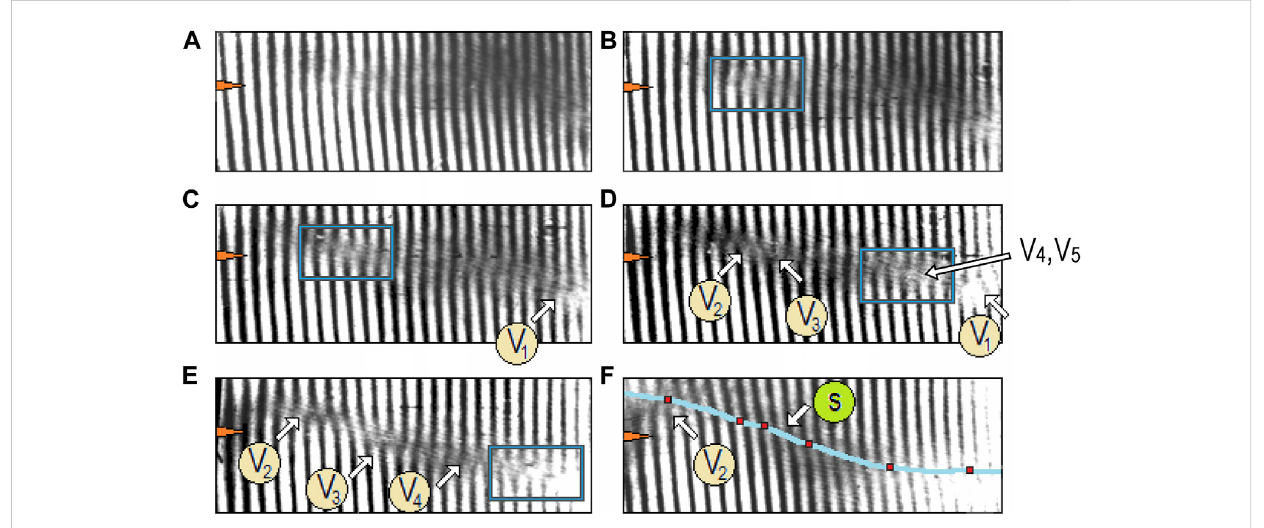
FIGURE 8 Results of the experimental investigation of the s -contour and the points of birth and annihilation of the vortices in planar polarization projections. Interferograms (A – F) correspond to different orientations of the polarizer 12 (Figure 7); light arrows on the left side of the images indicate the spatial reference. The detected s -contour is shown in the panel (F) by the light-blue